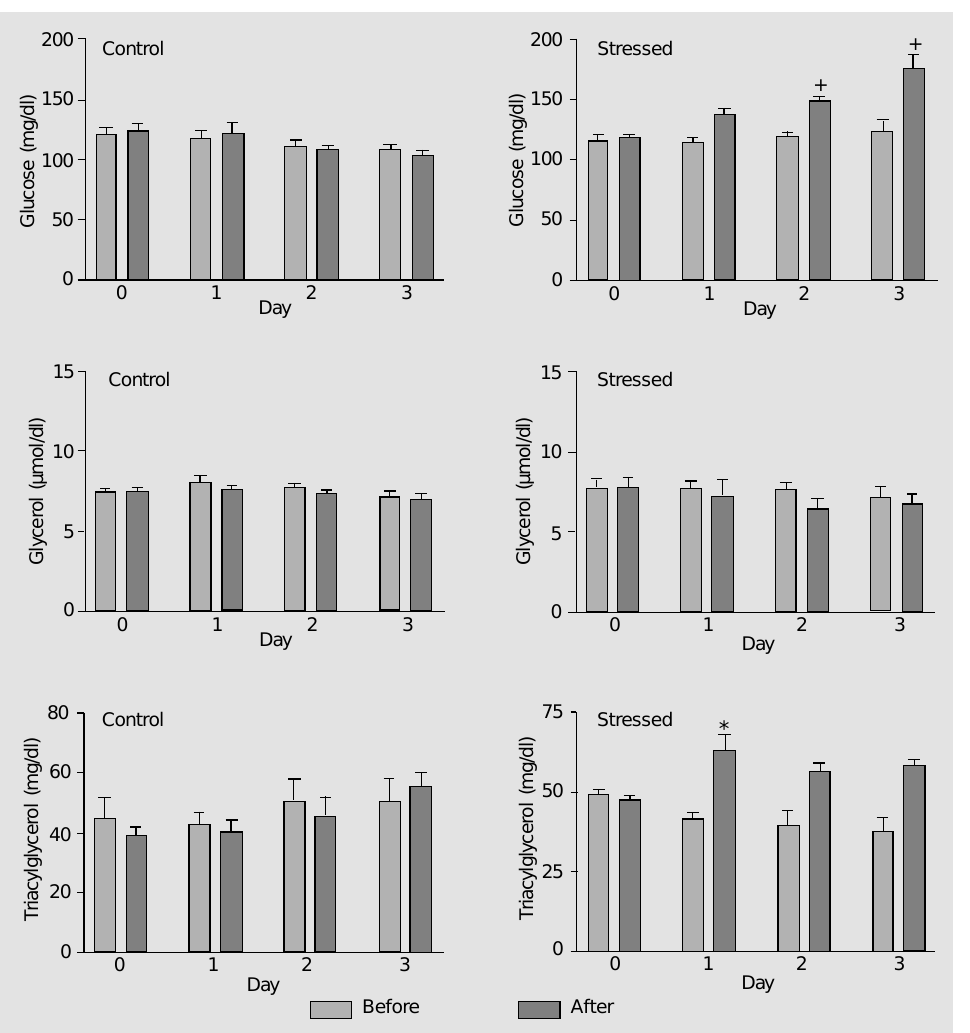
Figure 2. Plasma glucose, glyc- erol and triacylglycerol levels of fed conscious rats before and after the control procedure (left panels) or 30 min of footshock stress (right panels). On day 0, animals of both groups were placed in the footshock cage but did not receive footshocks (con- trol procedure). On days 1, 2 and 3, rats in the stressed group received 120 footshocks (1.0 mA, 1.0 s, intervals of 5-25 s between shocks) over a 30-min period. Rats from the control group remained in the foot- shock cage but did not receive footshocks. The columns repre- sent the means ± SEM of 5 ani- mals in each group. + P<0.05 compared to the control group before and after the session, and to the footshock group be- fore session (ANOVA plus Tukey test). *P<0.05 compared to the control group after the session and to the footshock group before the session (ANOVA plus Tukey